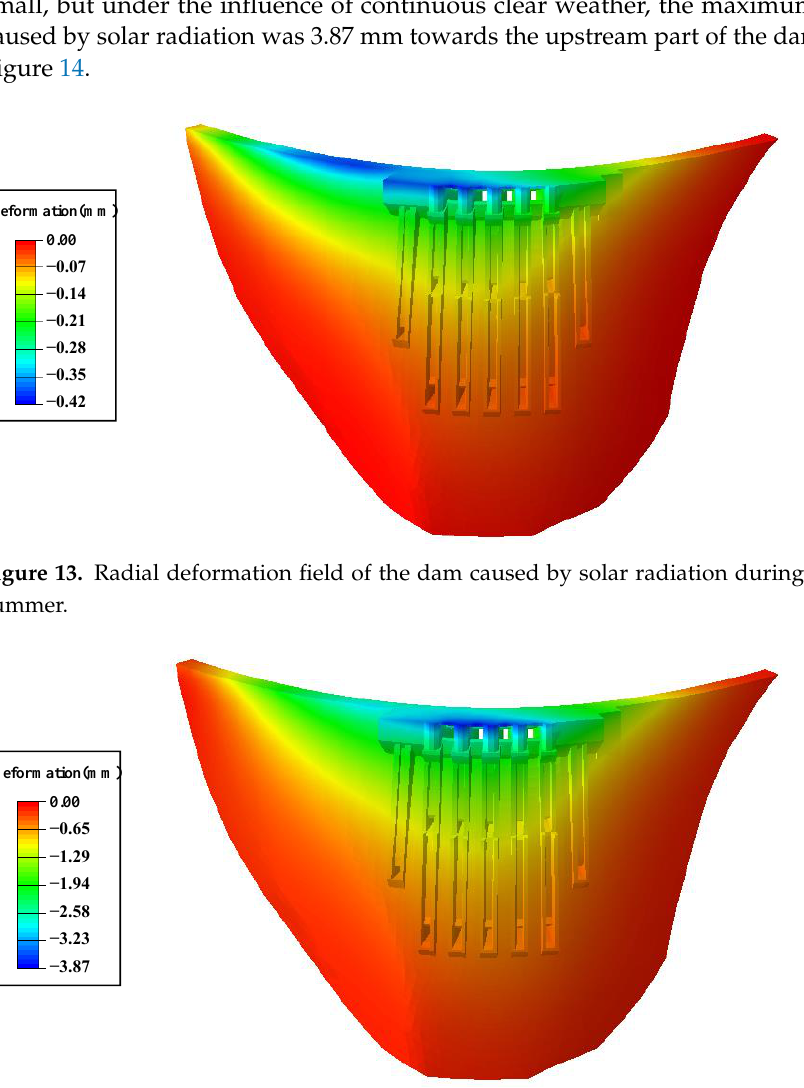
Figure 14. Dam annual cumulative radial deformation caused by solar radiation.